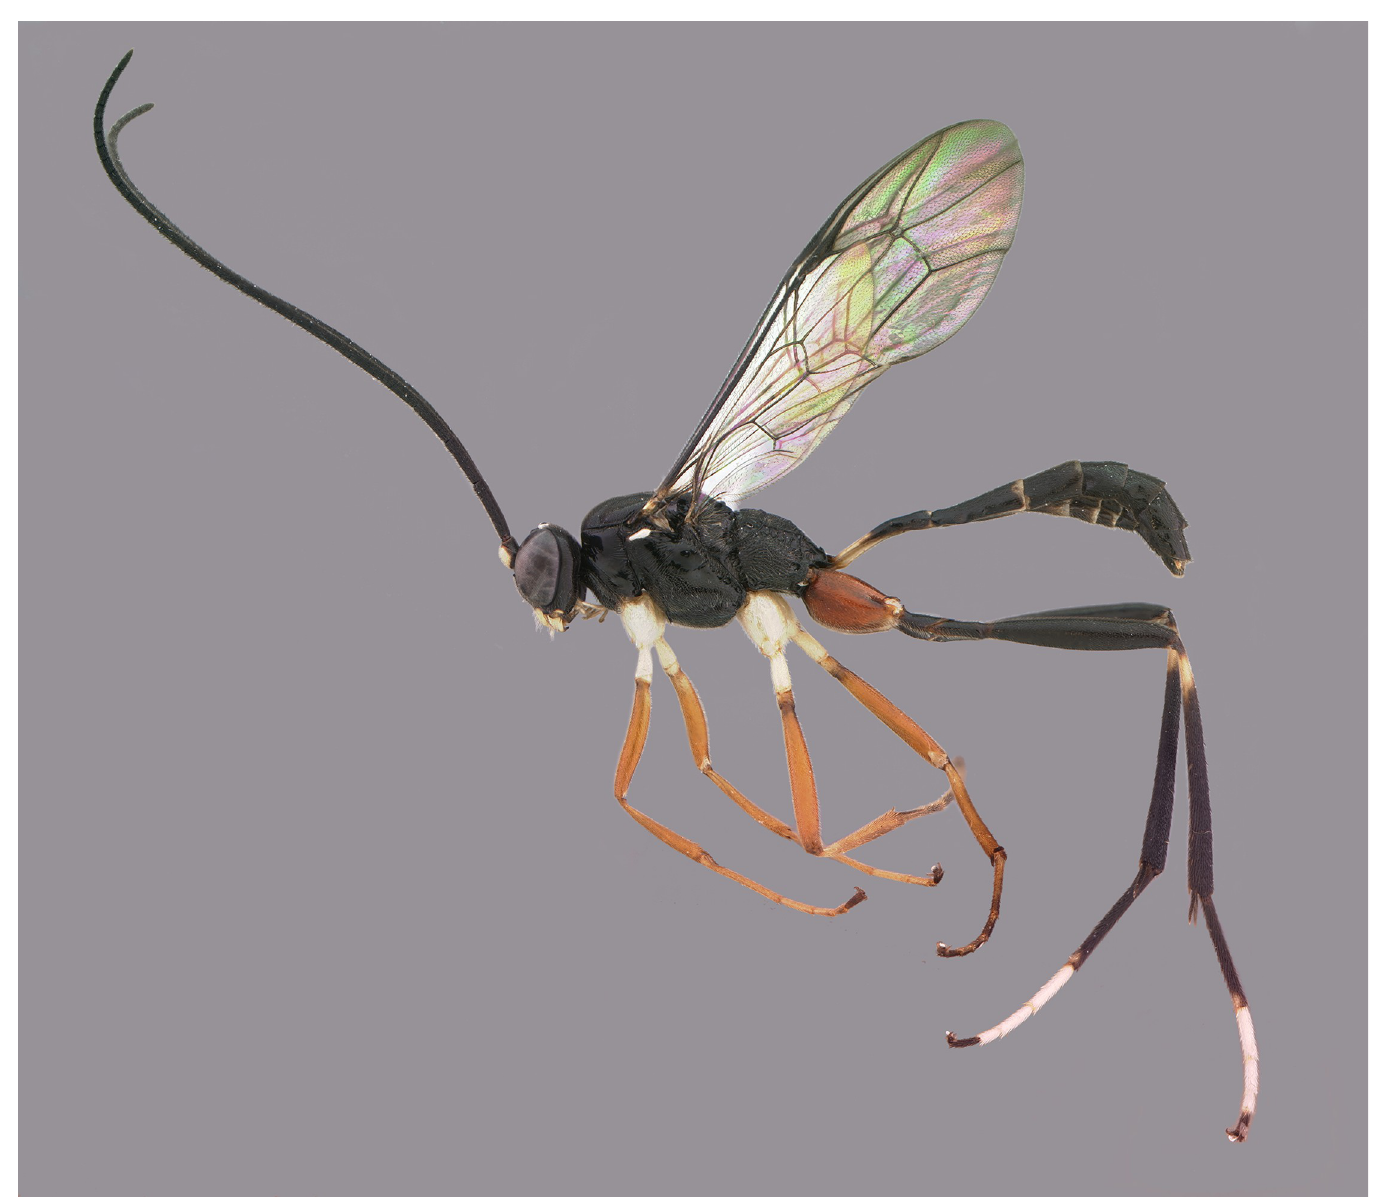
Fig 17. Paratype male of Cryptoxenodon metamorphus sp. nov. FAS2145, Alt. 501m, Brazil/ES. Habitus.